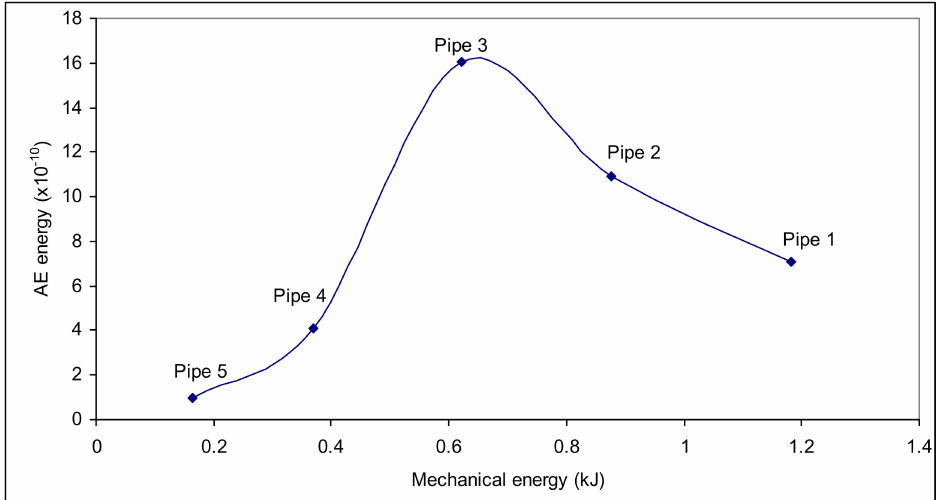
Figure 8. AE energy and mechanical